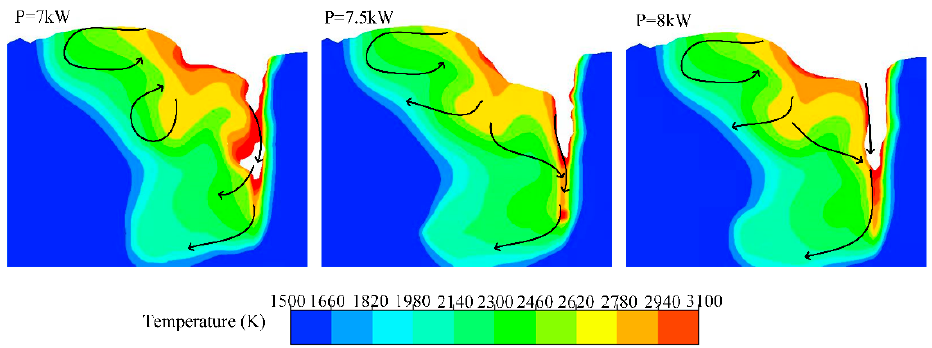
Figure 15. Melt flow in the longitudinal section of a hybrid weld with different laser powers.